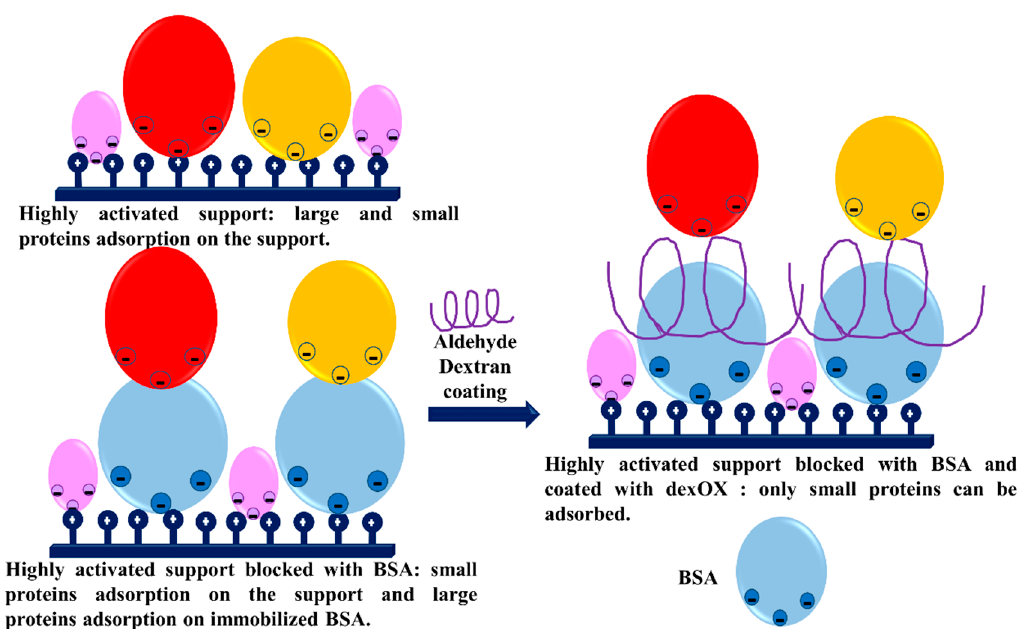
Figure 10. Selective ion exchange of small proteins using supports coated with BSA modified with dexOx.